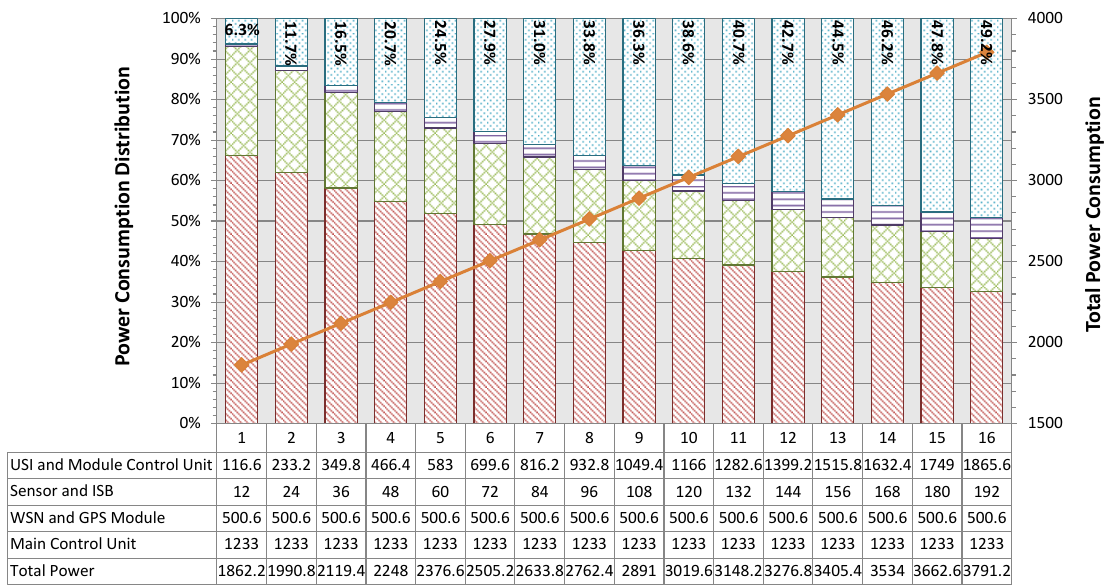
Figure 6. Power consumption distribution of the MSS sensor node with different numbers of gas Sensor-Modules (The data table is showing the exact power consumption of each major component with respect to the number of gas Sensor-Modules inserted. The unit of power consumption is mW. Each indicator in percentage on top of the rectangle column is the proportion of the total power consumption that was contributed by the USIs and module control